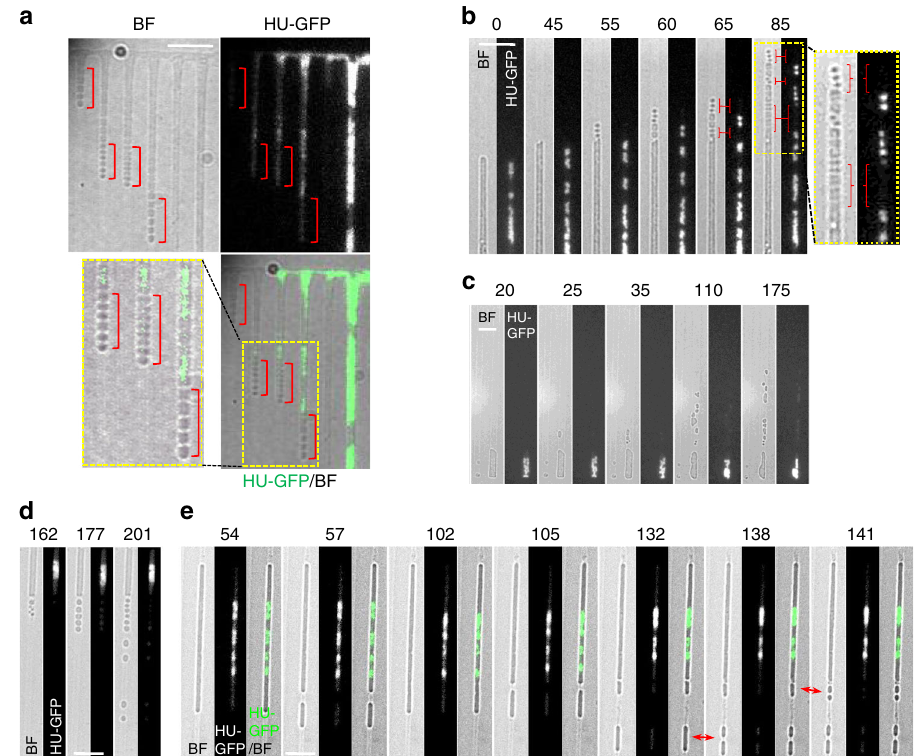
Fig. 5 DNA de fi ciency leads to DNA-free pearling division in channel-con fi ned L -forms. a , b DNA-less ‘ beads ’ produced by L-forms in narrow channels under normal growth conditions. Scale bars, 5 µ m. Brackets: DNA-free, bead-like cells. a Cells in the gutter grew into the narrow channels (0.8 – 1.0 µ m) with the mass of the nucleoid excluded from entry, generating strings of DNA-less beads in the channels. A bright fi eld image is shown on the top left, chromosomal DNA labelled with HU-GFP on the top right, and a merge of the two on the bottom right (GFP in green). Yellow boxed region is enlarged and shown at the bottom left. These are selected still frames from Supplementary Movie 11. Strain: 4739 (LR2 Ω amyE :: neo hbsU-gfp ). b Small DNA-less cells in narrow channels. Each time frame (min) shows bright fi eld images on the left and chromosomal DNA labelled with HU-GFP on the right. Yellow boxed region is enlarged and shown on the right. Strain: 4742 (LR2 Ω amyE :: neo hbsU-gfp aprE::P rpsD -mCherry spc) . c A cell, appeared to be defective in chromosome replication/segregation (for unknown reason), produced many small DNA-free daughter cells of various sizes. These are selected still frames from Supplementary Movie 10. The cell shown was in a 2.2 µ m wide channel (Chip No. 7). Each time frame (min) shows bright fi eld images on the left and chromosomal DNA labelled with HU-mCherry on the right. Strain: 4739 (LR2 Ω amyE :: neo hbsU-gfp ). Scale bar, 5 µ m. d , e Examples of L -forms inhibited for DNA replication generating regular pearling ( d ) or large DNA-free cells ( e ) in the DNA de fi cient regions in narrow channels. L-forms of strain 4739 (LR2 Ω amyE :: neo hbsU-gfp) were grown in the presence of the DNA replication inhibitor HB-EmAu in liquid culture and after introduction into a micro fl uidic device. These are selected still frames from Supplementary Movies 11 (for d ) and 12 (for e ). Red arrows in e shows anucleate cells dividing. Scale bars, 5 µ m. The experiment in ( c ) was performed twice and the other experiments were performed more than three times, independently, with similar